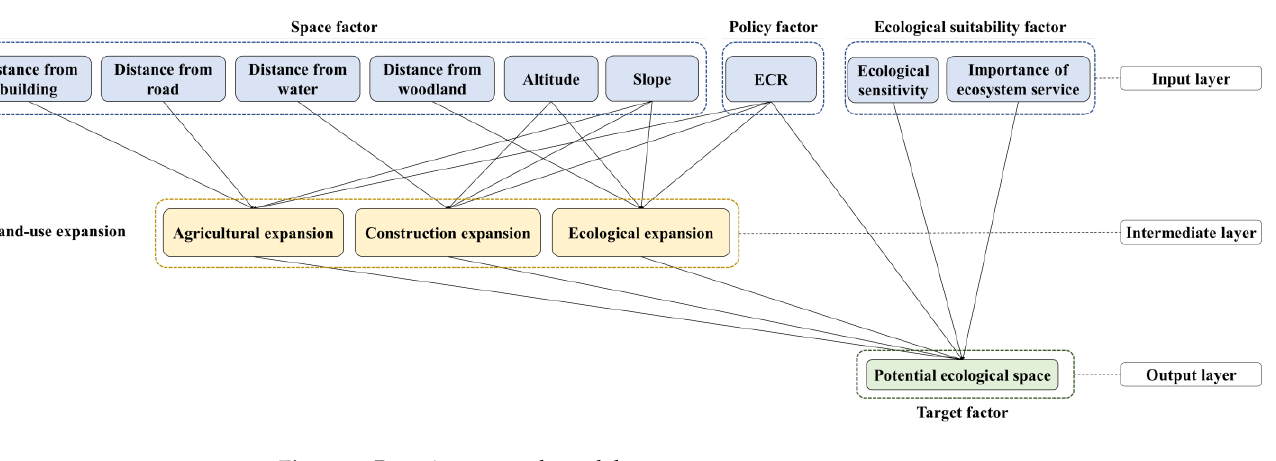
Figure 5. Bayesian network model structure.